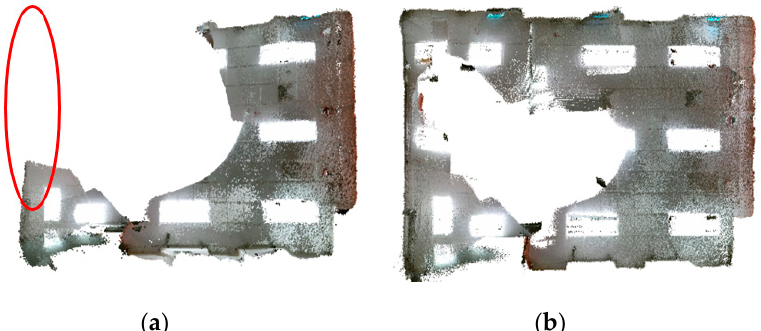
Figure 9. Reconstruction 3D models from simultaneous localization and mapping (SLAM) systems ( a ) ORB-SLAM2; ( b ) Proposed.